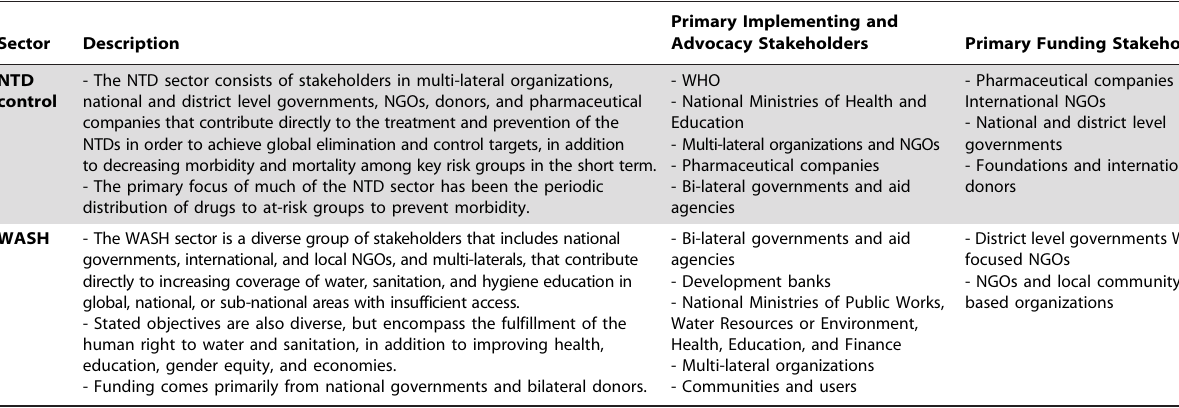
Table 2. Definitions of WASH and NTD